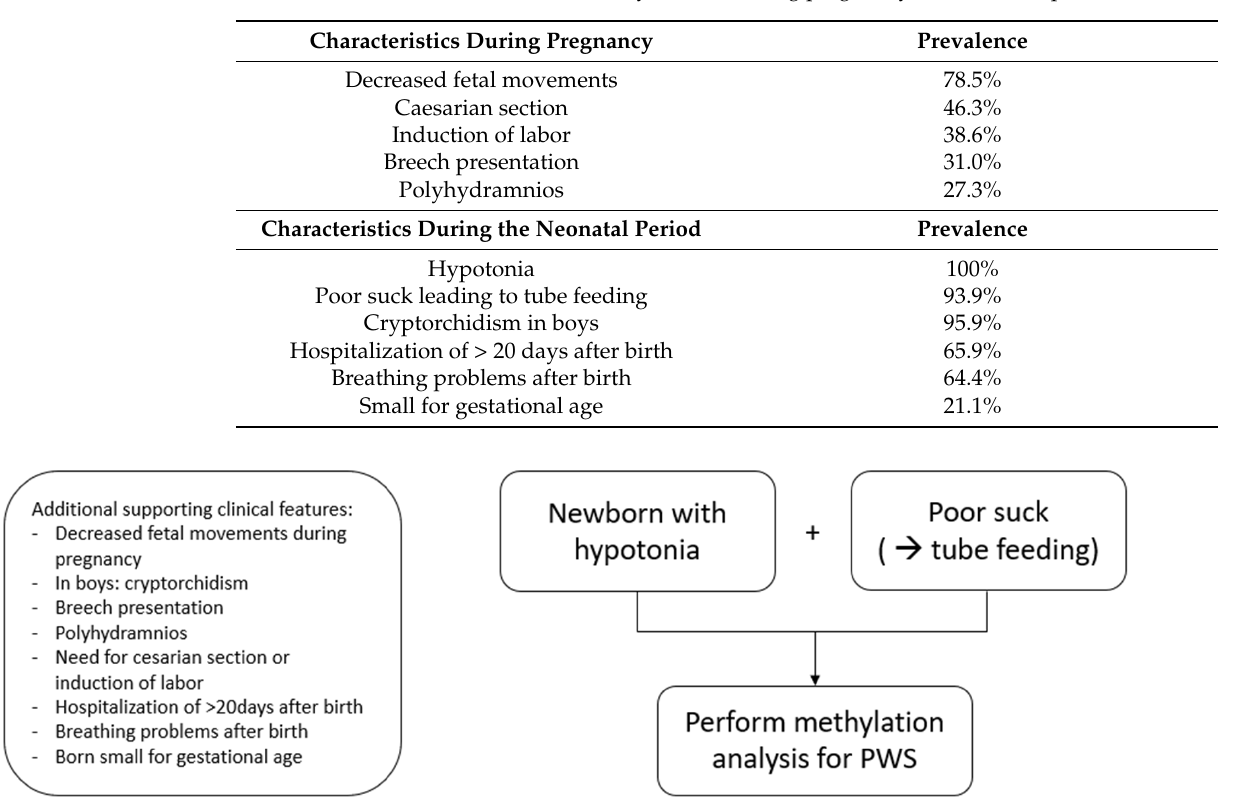
Table 4. Characteristics of Prader-Willi Syndrome during pregnancy and neonatal period.